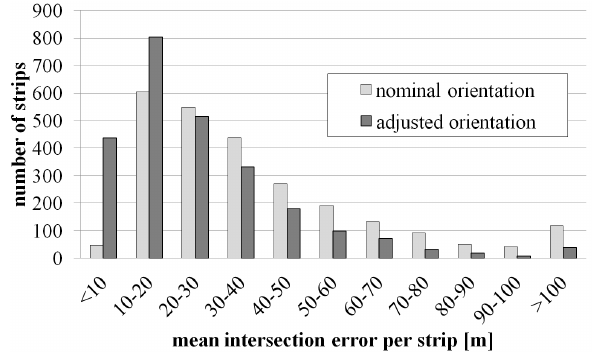
Figure 5: Number of strips grouped by their mean intersection error before (light gray) and after (dark gray) the improvement of the exterior orientation by bundle adjustment